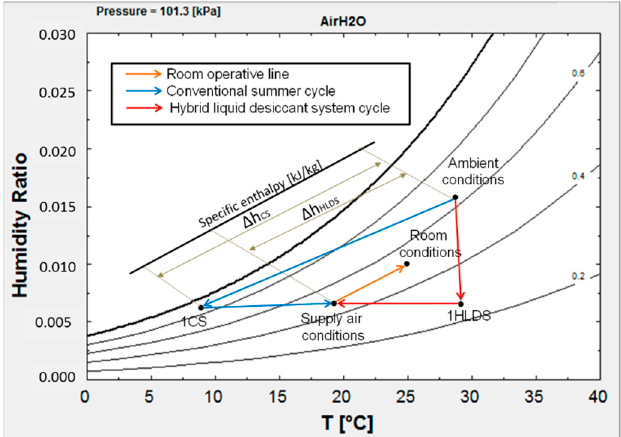
Figure 11. Conventional air handling unit cycle and HLDS cycle to control humidity and tempera- ture separately.